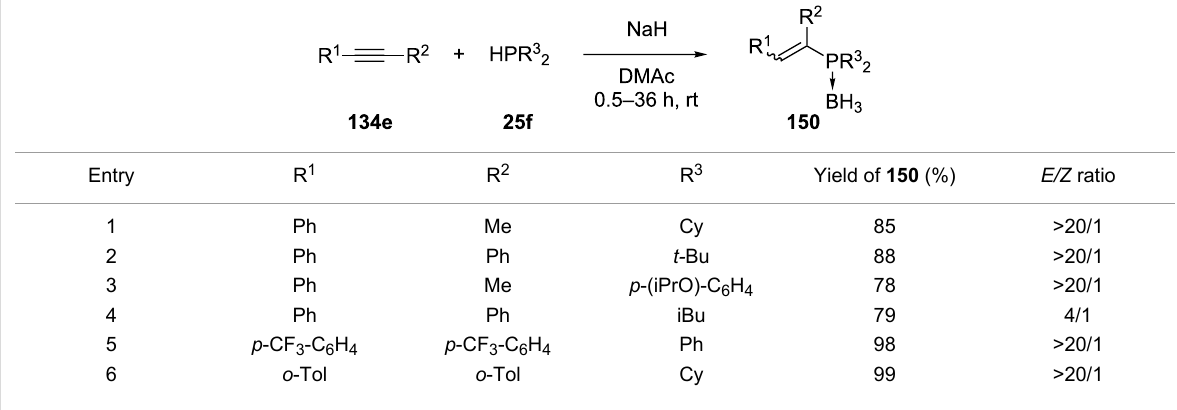
Table 19: Hydrophosphination of alkynes 134e with phosphine–borane complexes 25f (DMAc =